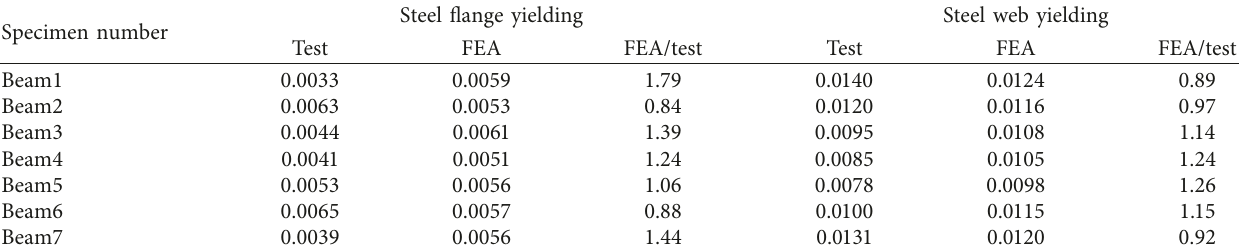
Table 6: Comparison of chord rotations of specimens for different steel damage states. Specimen number